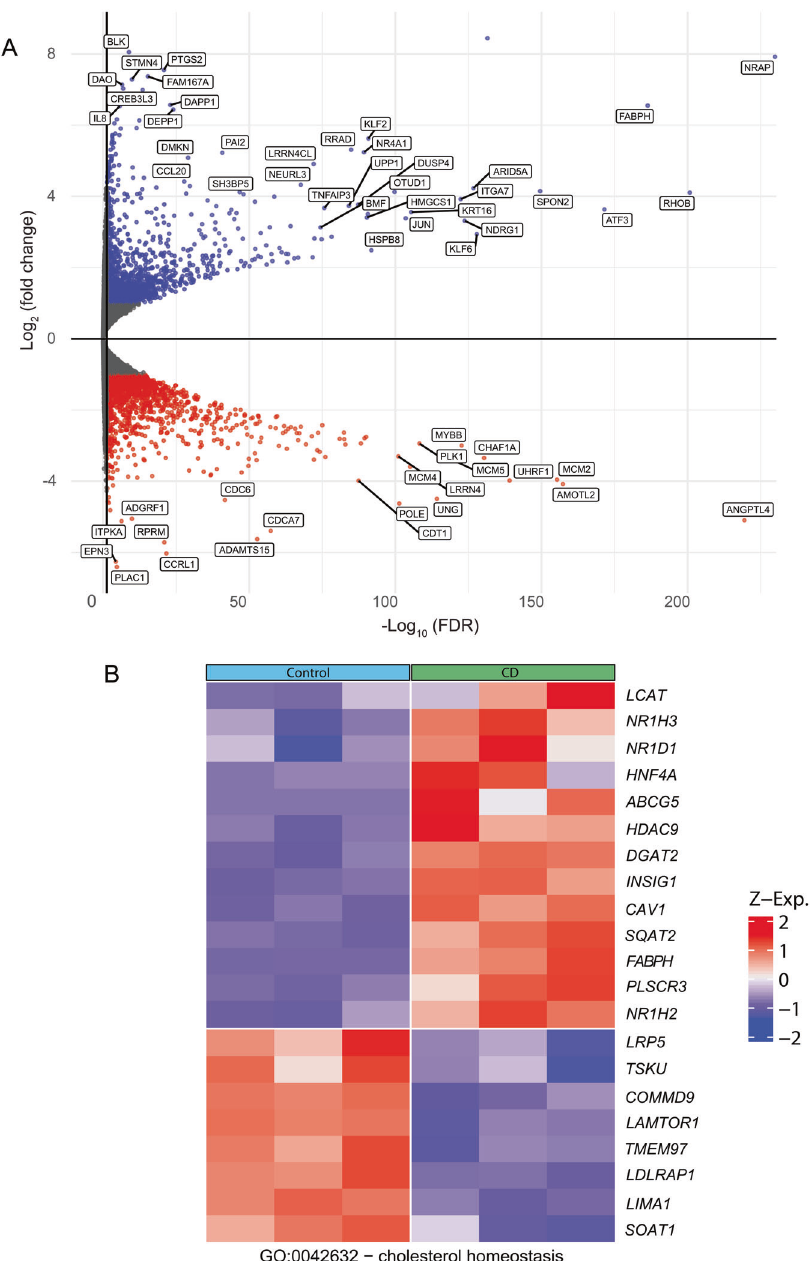
Fig. 1 Cholesterol depletion alters mRNA levels of a large number of genes, including cholesterol homeostasis genes. Mv1Lu cells were treated (or not) by statin in the presence of mevalonate and LPDS (16 h) to reduce their cholesterol level, and then subjected to RNA-Seq (see “ Materials and methods ” ). A Volcano plot depicts genes with signi fi cantly increased or reduced expression levels following CD relative to untreated cells. B Heat map of differentially expressed genes related to cholesterol homeostasis. Only those genes with signi fi cant differential expression (FDR < 0.05) are